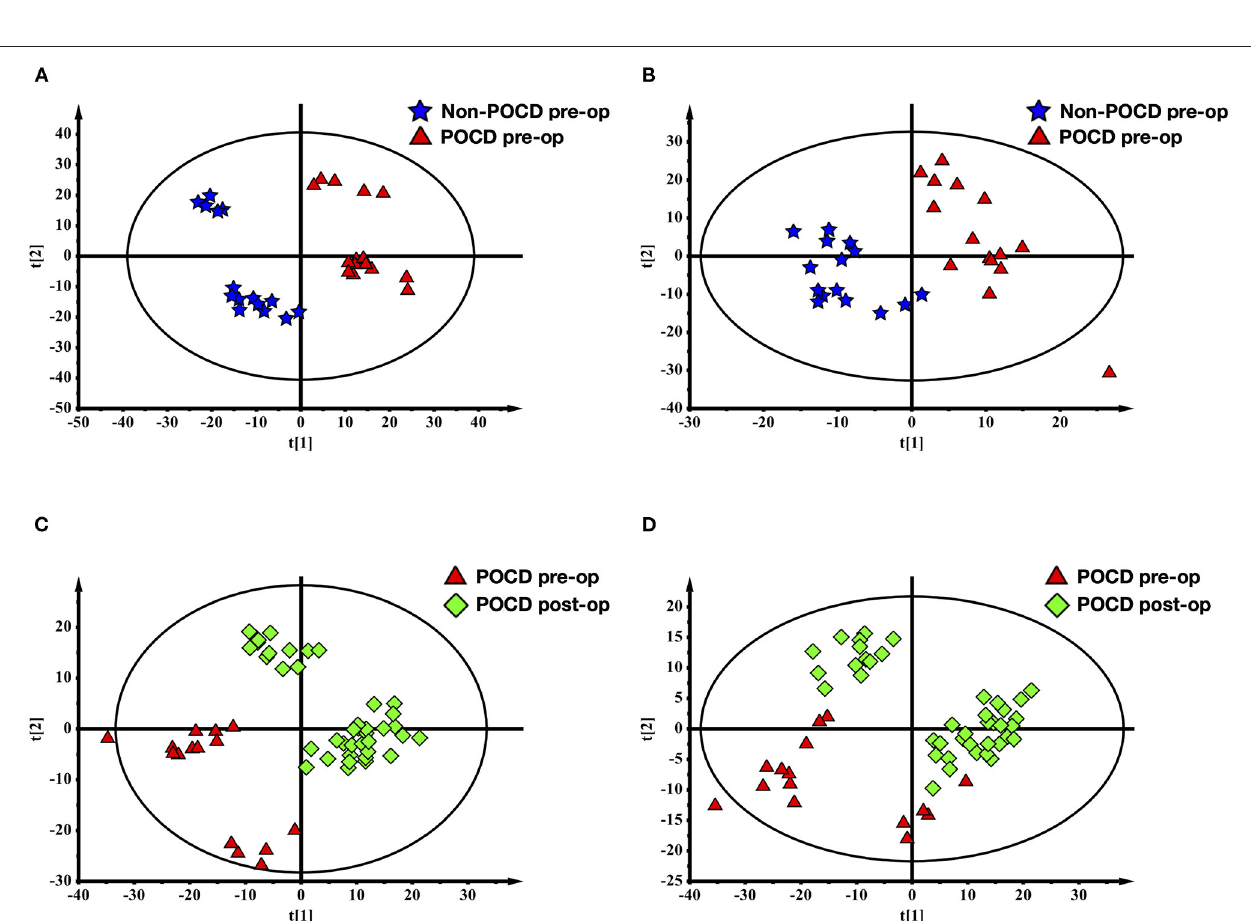
FIGURE 3 | Partial least squares discriminant analysis (PLS-DA) of blood metabolomics data from before and after surgery POCD groups. Blood metabolites distinguished before and after surgery in patients with POCD. The blue stars represented before surgery POCD patients and the red triangles represented after surgery POCD patients in the two-dimensional PLS-DA score